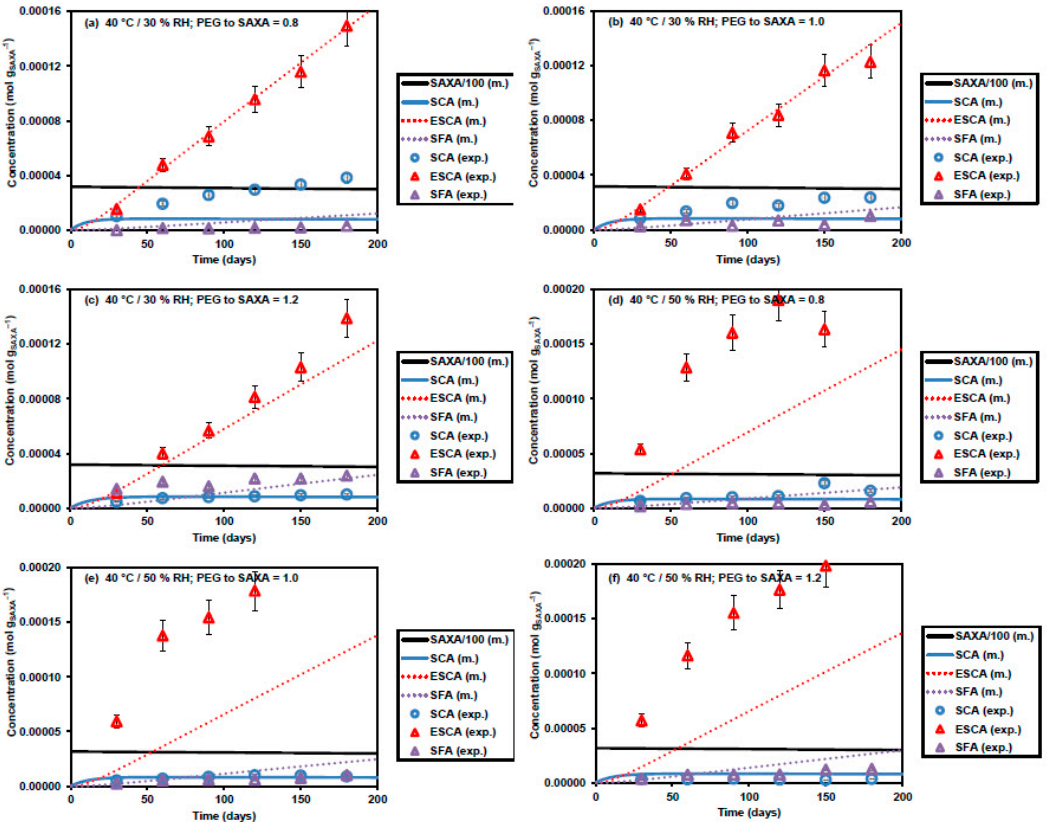
Figure 7. The concentration of saxagliptin (SAXA) degradation products (amidine (SCA), epimer (ESCA),andformylamide(SFA))( a – f )reactions. Linesrepresentfittedmodel(m.), markersexperimental data points (exp.). Tablet degradation tests were executed at the temperature of 40 ◦ C, the nominal water activity of 30% ( a – c ) or 50% ( d – f ), and the initial polyethylene glycol (PEG) to SAXA weight ratios of 0.8 ( a , d ), 1.0 ( b , e ), and 1.2 ( c , f ). The data for the measurements at 40 ◦ C, 10%, and 0.8–1.4 PEG to SAXA is presented in the Figure 6, respectively. A relative error of 10% is set based on sum of estimated analytical and sample